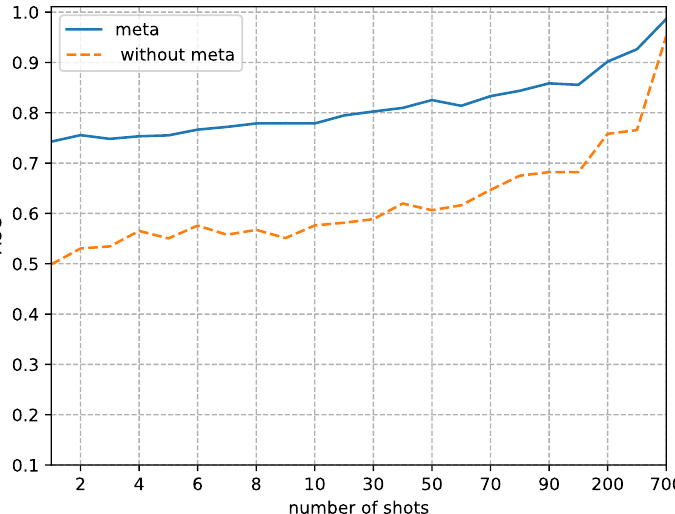
Figure 9. Comparison of AUC between random initial weights (without the proposed method) and meta-learning of detecting images altered by Face2Face manipulation methods. The x-axis is the size of the fine-tuned training set and the y-axis is the value of AUC.